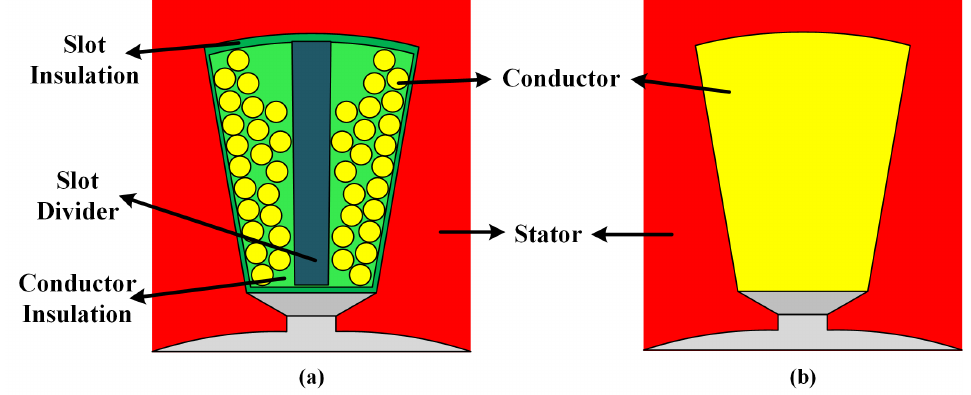
Figure 9. Winding distribution and illustration of slot fill factor. ( a ) Double-layer winding distribution. ( b ) Single-turn winding distribution.